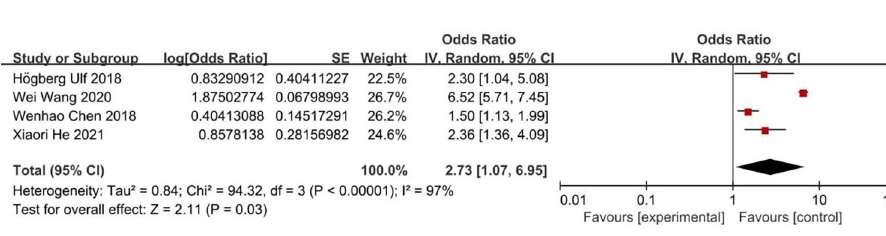
Fig 5. Forest diagram of the relationship between gestational age < 32 weeks and the incidence of